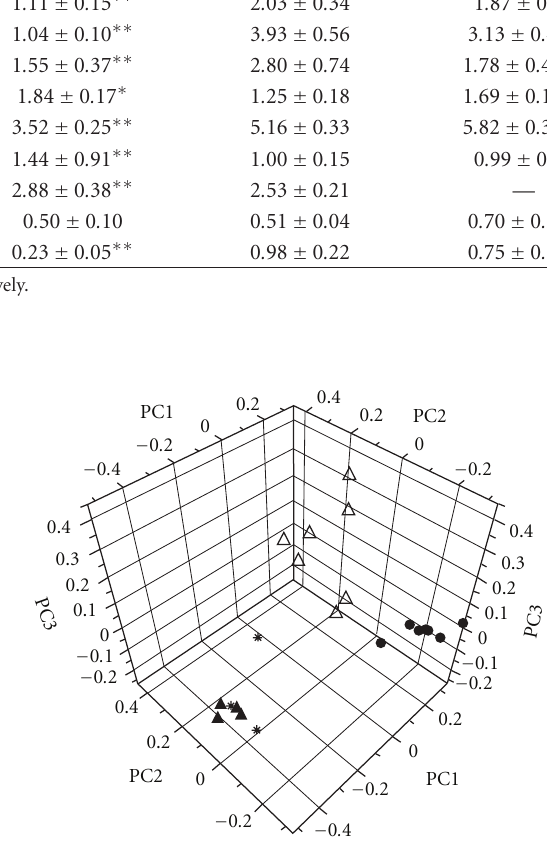
energy metabolism. It is known that the mitochondria pro- duce more than 90% of energy ATP by ox-phos [18].